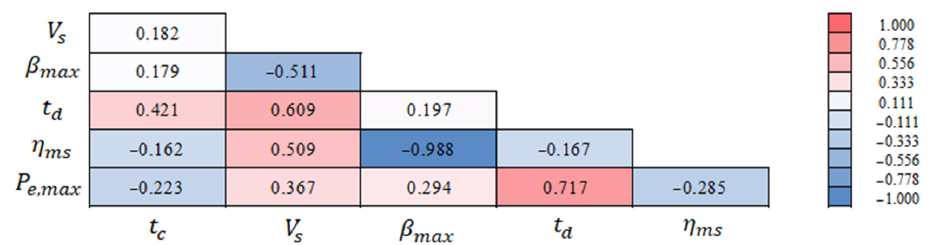
variables ( 𝑃 (cid:3032),(cid:3040)(cid:3028)(cid:3051) , 𝑡 (cid:3031) , 𝜂 (cid:3040)(cid:3046) ).